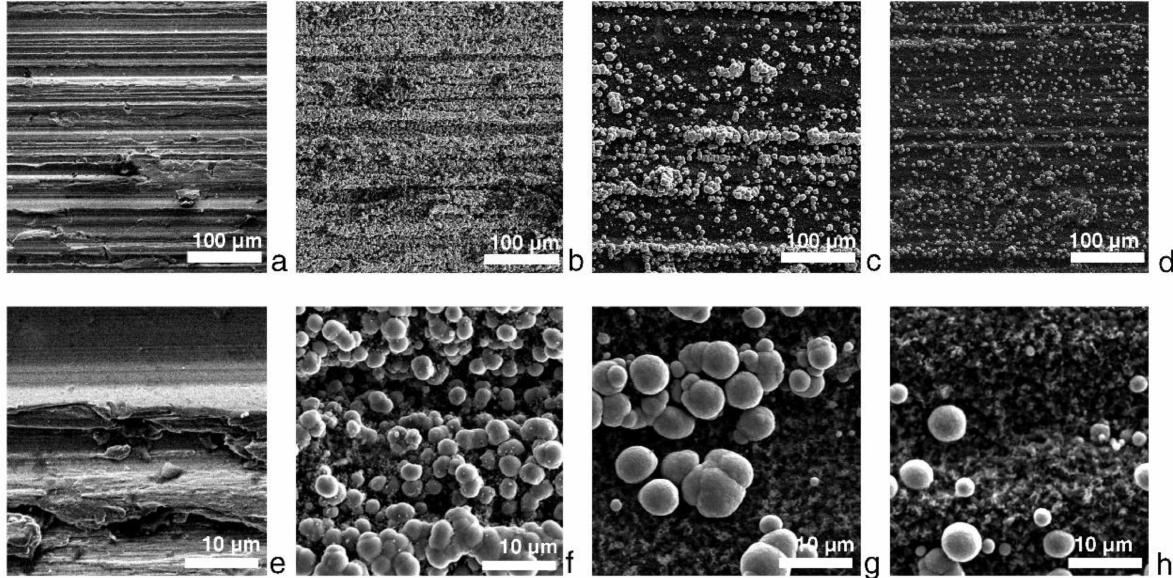
Figure 3. Effect of the temperature used during CVD process: ( a , e ) SS as provided, at ( b , f ) 500 ◦ C, ( c , g ) 600 ◦ C, ( d , h ) 700 ◦